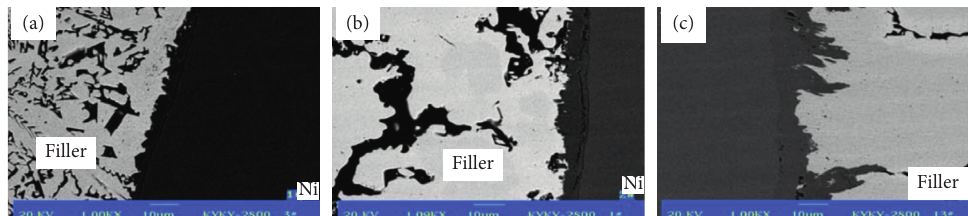
Figure 12: Cross-sectional electron images of Au-Ag-Si/Ni solder joint at different soldering temperatures: (a) 472 ° C, (b) 492 ° C, and (c) 512 ° C [66].